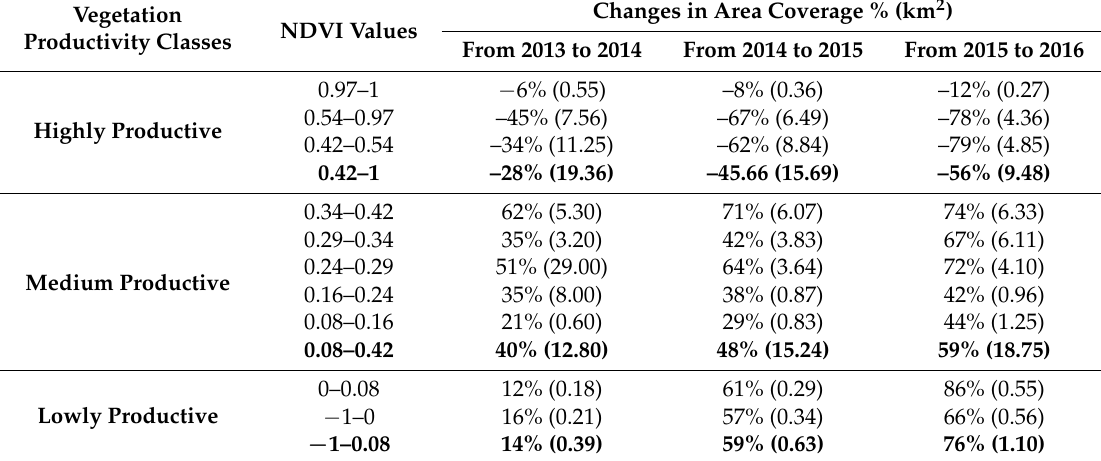
Figure 6. ( a ) NDVI map of the Kirchheller Heide mining area in July 2013, 2014, 2015, and 2016. Value ranges 0.42–1, 0.08–0.42, and − 1–0.08 indicated highly, medium, and lowly productive vegetation, respectively (see b and Table 4 for details). The location of the waterbodies, which experienced abrupt growth, are in the black circles; ( b ) Area coverage in km 2 by vegetation productivity classes in 2013, 2014, 2015, and 2016. Table 4. Vegetation productivity changes between 2013–2014, 2014–2015, and 2015–2016. Value ranges 0.42–1, 0.08–0.42, and − 1–0.08 indicated highly, medium, and lowly productive vegetation, respectively, and the overall changes in their coverage are reported in bold.